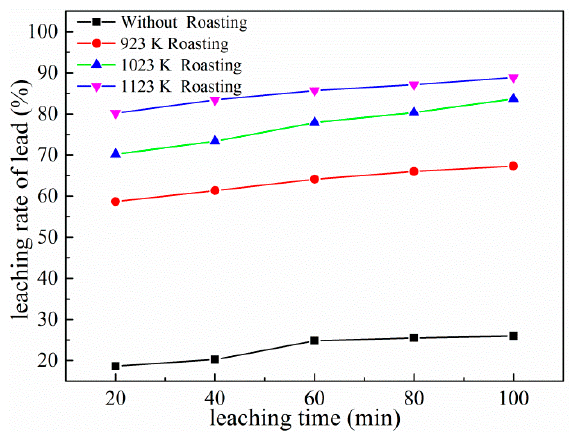
Figure 5. Effects of roasting pretreatment on leaching of lead. Figure 5. E ff ects of roasting pretreatment on leaching of